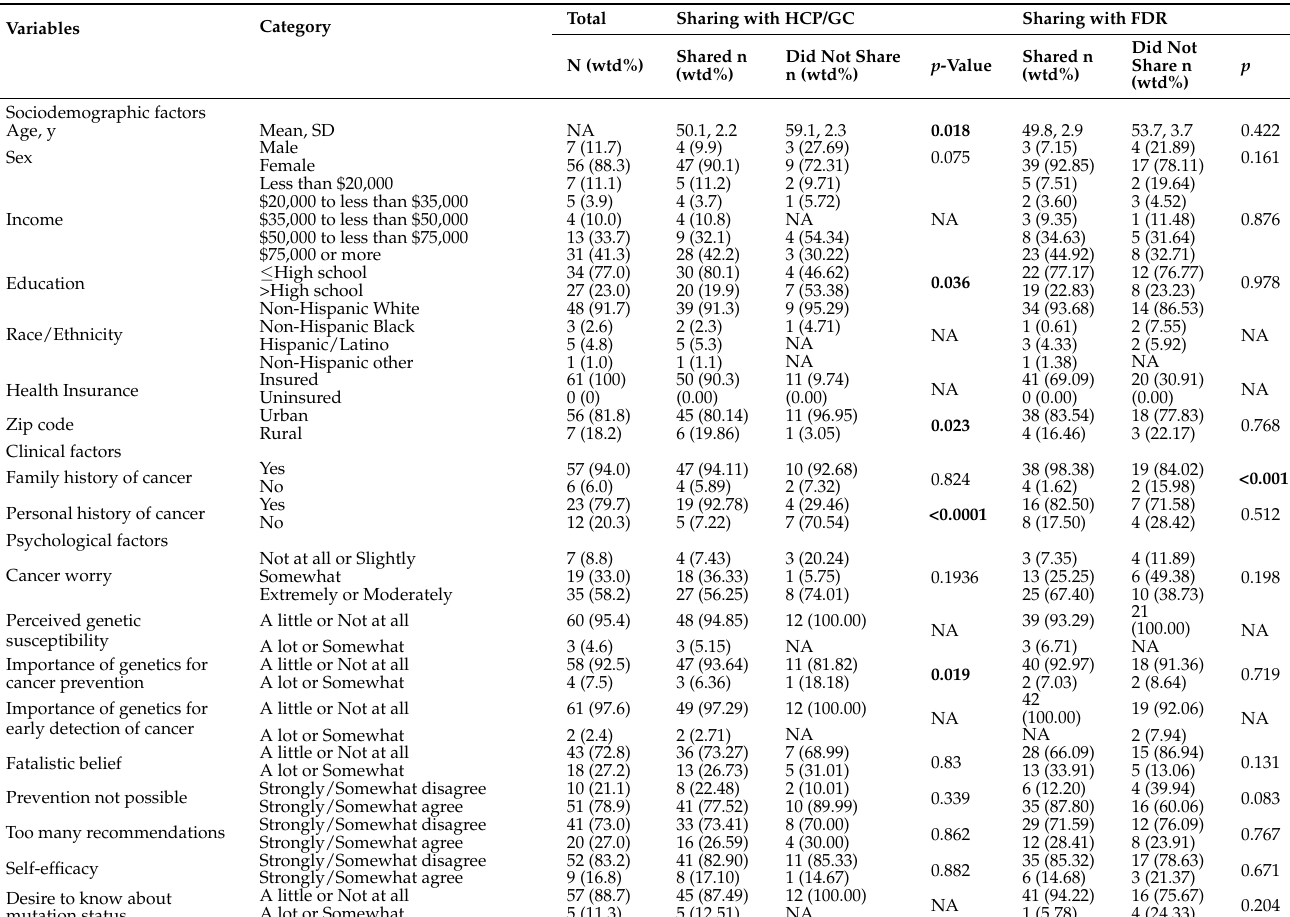
Figure 1. Sharing behavior of clinical and direct-to-consumer genetic test results. For each type of genetic test result, respondents answered the question, “ . . . who did you share the results with?” Selecting multiple answers was allowed. Table 1. Descriptive characteristics of individuals who shared results from high-risk cancer genetic testing.